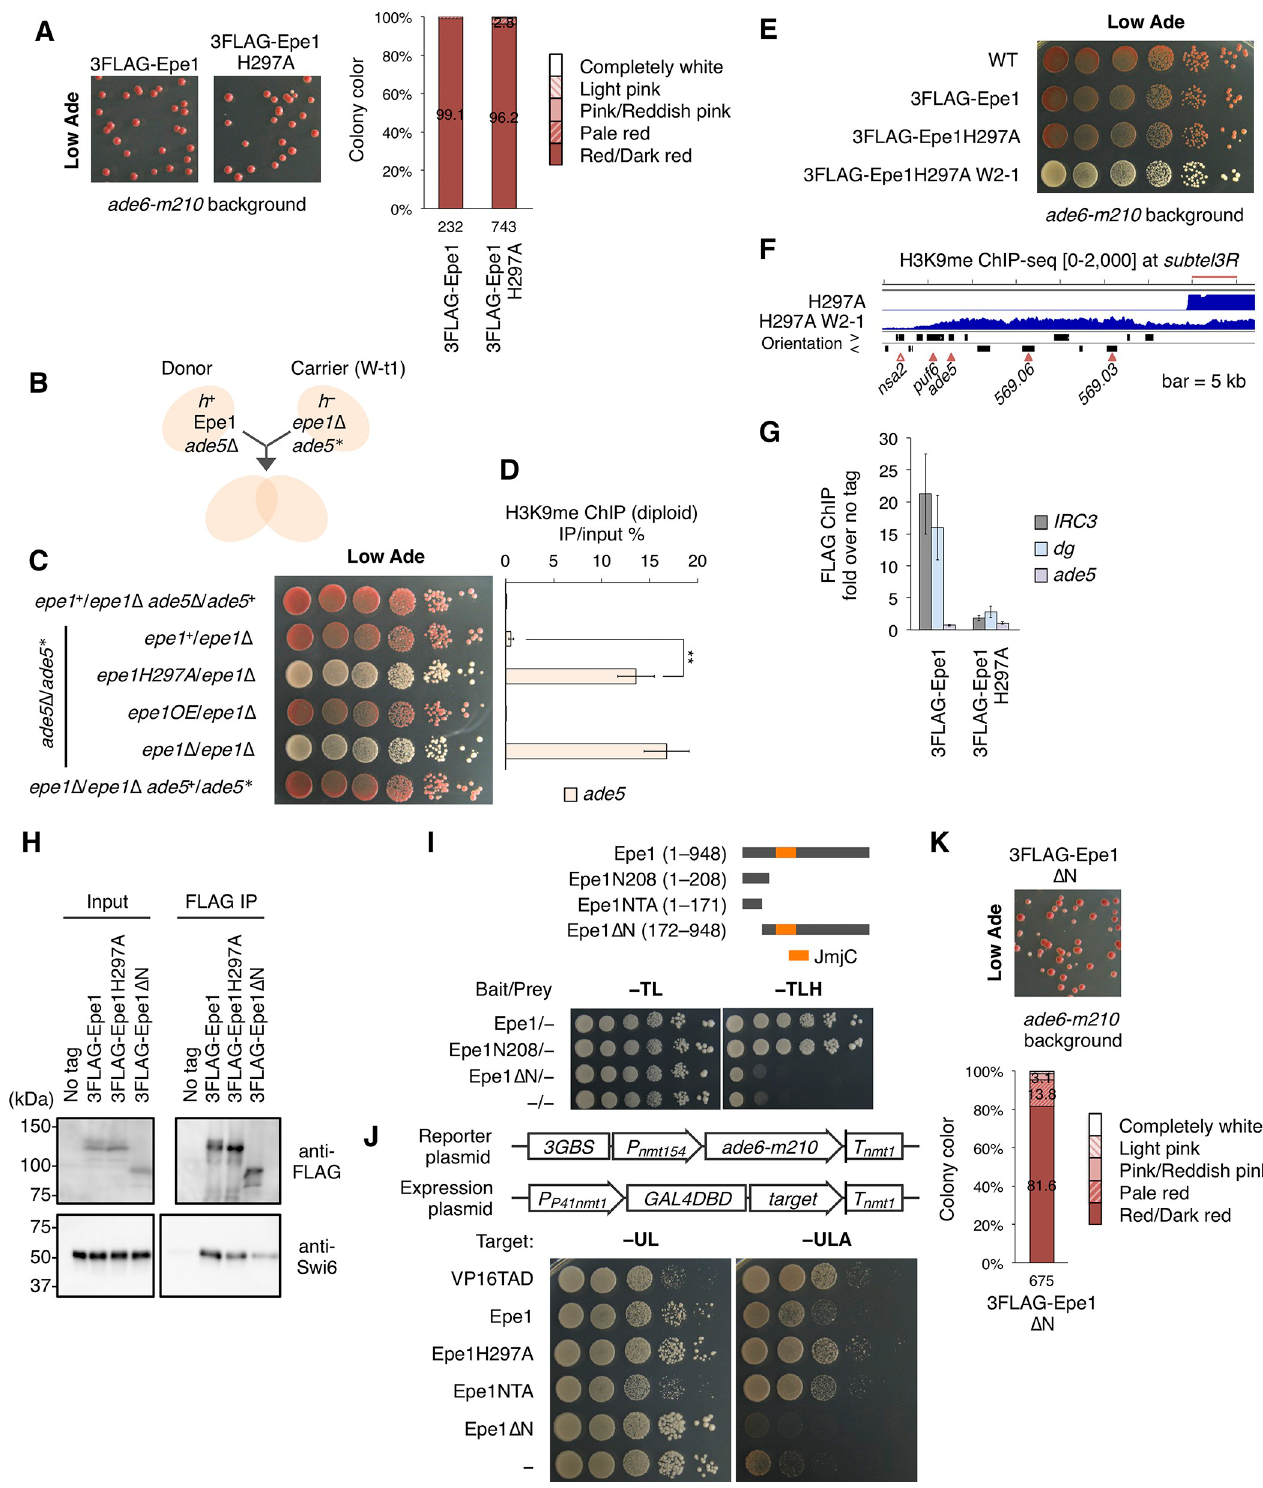
Fig 4. Epe1 prevents the ectopic heterochromatin-mediated red-white variegation via an N-terminal transcriptional activation domain-dependent mechanism. (A) Comparison of colony color of strains expressing the 3FLAG-tagged Epe1 protein and H297A JmjC domain mutant on adenine-limited medium (left). Eight percent of the plate area is displayed. Percentage of colored and white colonies is shown to the right. (B) Schematic representation of the diploid complementation analysis. The epe1 Δ W-t1 strain was used as a carrier strain, which harbored ade5 ectopic heterochromatin ( ade5 � ). (C) Ten-fold serial dilution assay for diploid strains. The indicated strains were spotted onto adenine-limited medium. (D) ChIP-qPCR analysis of H3K9me for diploid cells at ade5 . The qPCR signals were monoallelic. �� p < 0.05 (two-tailed Student’s t -test). (E) Ten-fold serial dilution assay of 3FLAG-Epe1H297A and W2-1 white- isolated strains. (F) ChIP-sequencing analysis of H3K9me. subtel3R is shown. Bar, 5 kb. (G) ChIP-qPCR analysis of FLAG-tagged Epe1 proteins at IRC3 , dg , PLOS Genetics | https://doi.org/10.1371/journal.pgen.1008129 June 17,